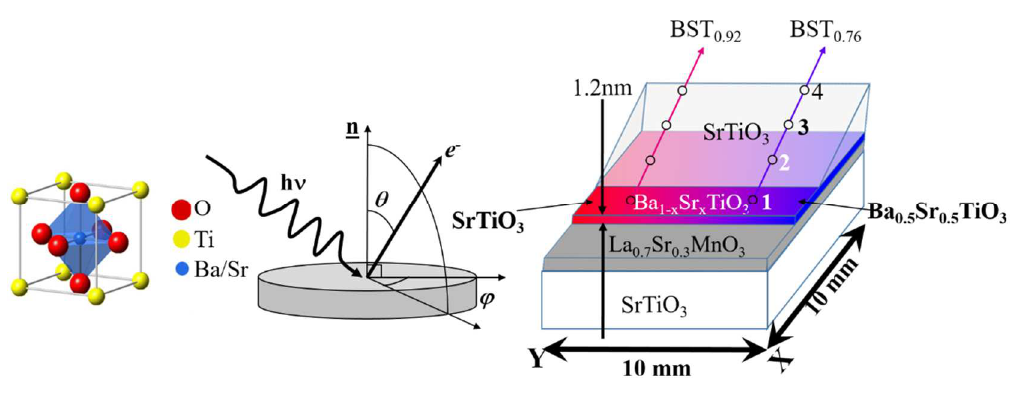
Fig. 1. Schematic of the ferroelectric STO/LSMO (22 nm)/BSTx (1.2 nm)/STO (1.1 nm – 15.4 nm) sample grown by combinatorial pulsed laser deposition and investigated with angle-resolved X-ray photoemission spectroscopy.